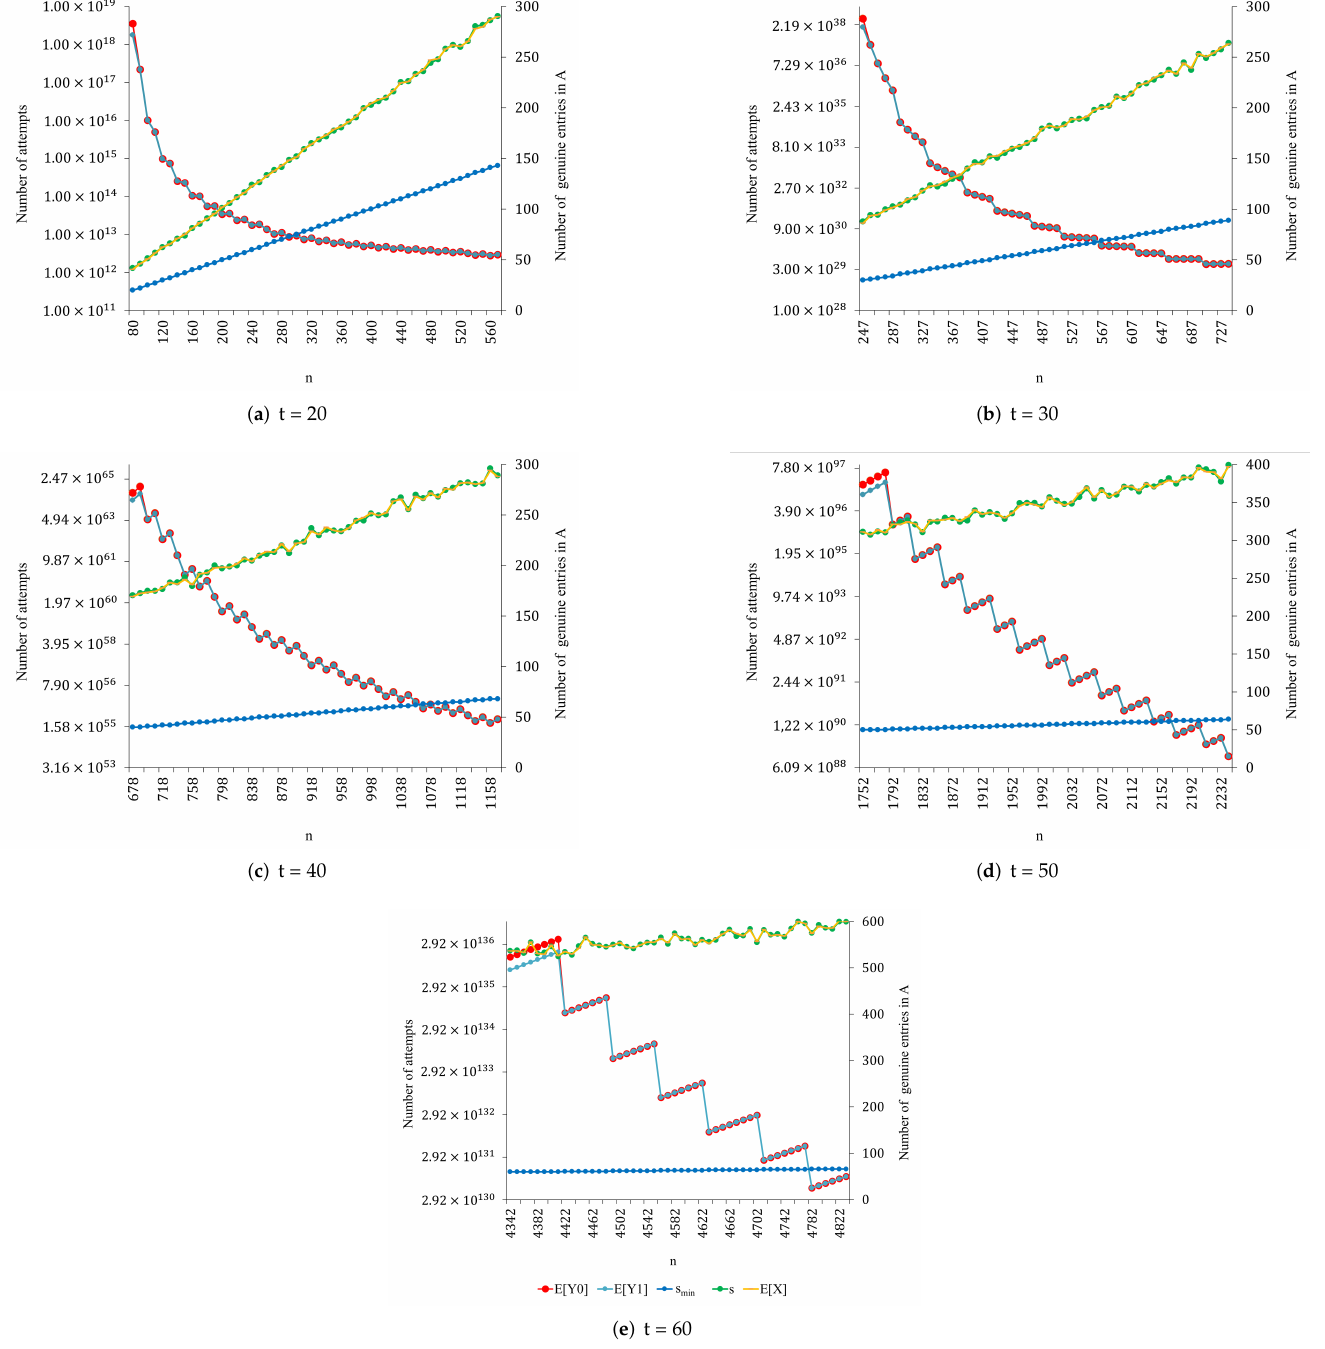
Figure 3. Results obtained for p min = 0.93 ∈ P , t ∈ T , and proper values of n